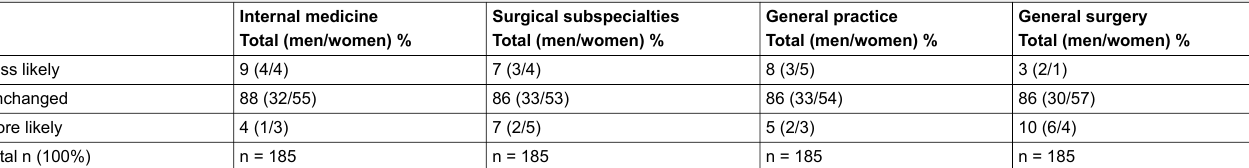
Table 5: Students’ indication of their three favourite career choices: Changes of the top three specialty choices and of general surgery after the surgical